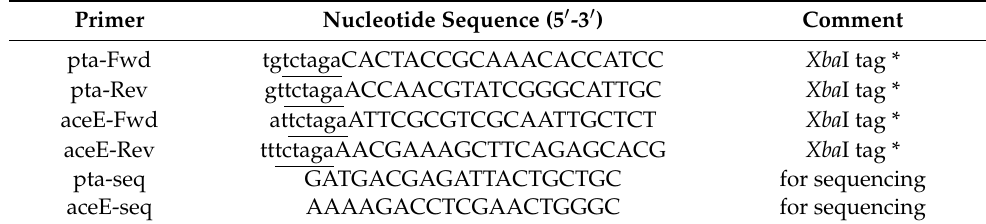
Table 2. Primers used for the construction of isogenic mutants. Primer Nucleotide Sequence (5 (cid:48) -3 (cid:48)